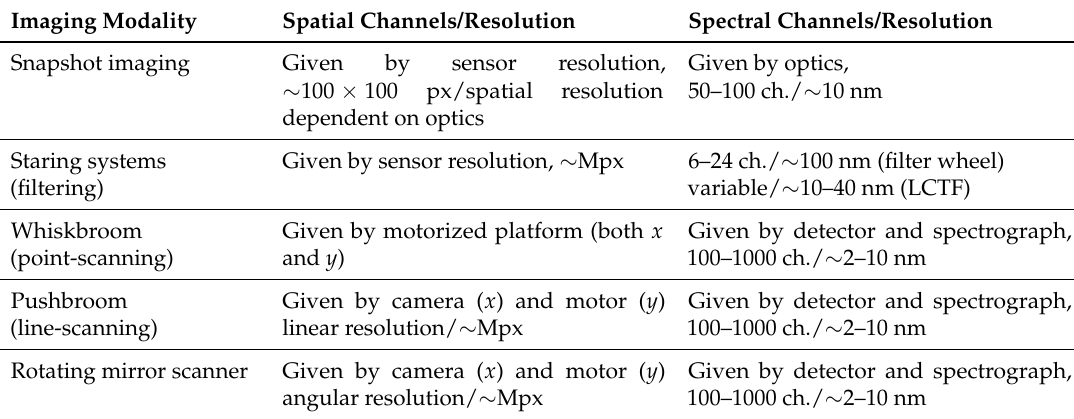
Table 1. Frequent far-field reflectance hyperspectral imaging systems for biomedical applications, with its properties and applications (summary from [13,23]). Most devices trade off spatial, spectral resolution, and speed, depending on the